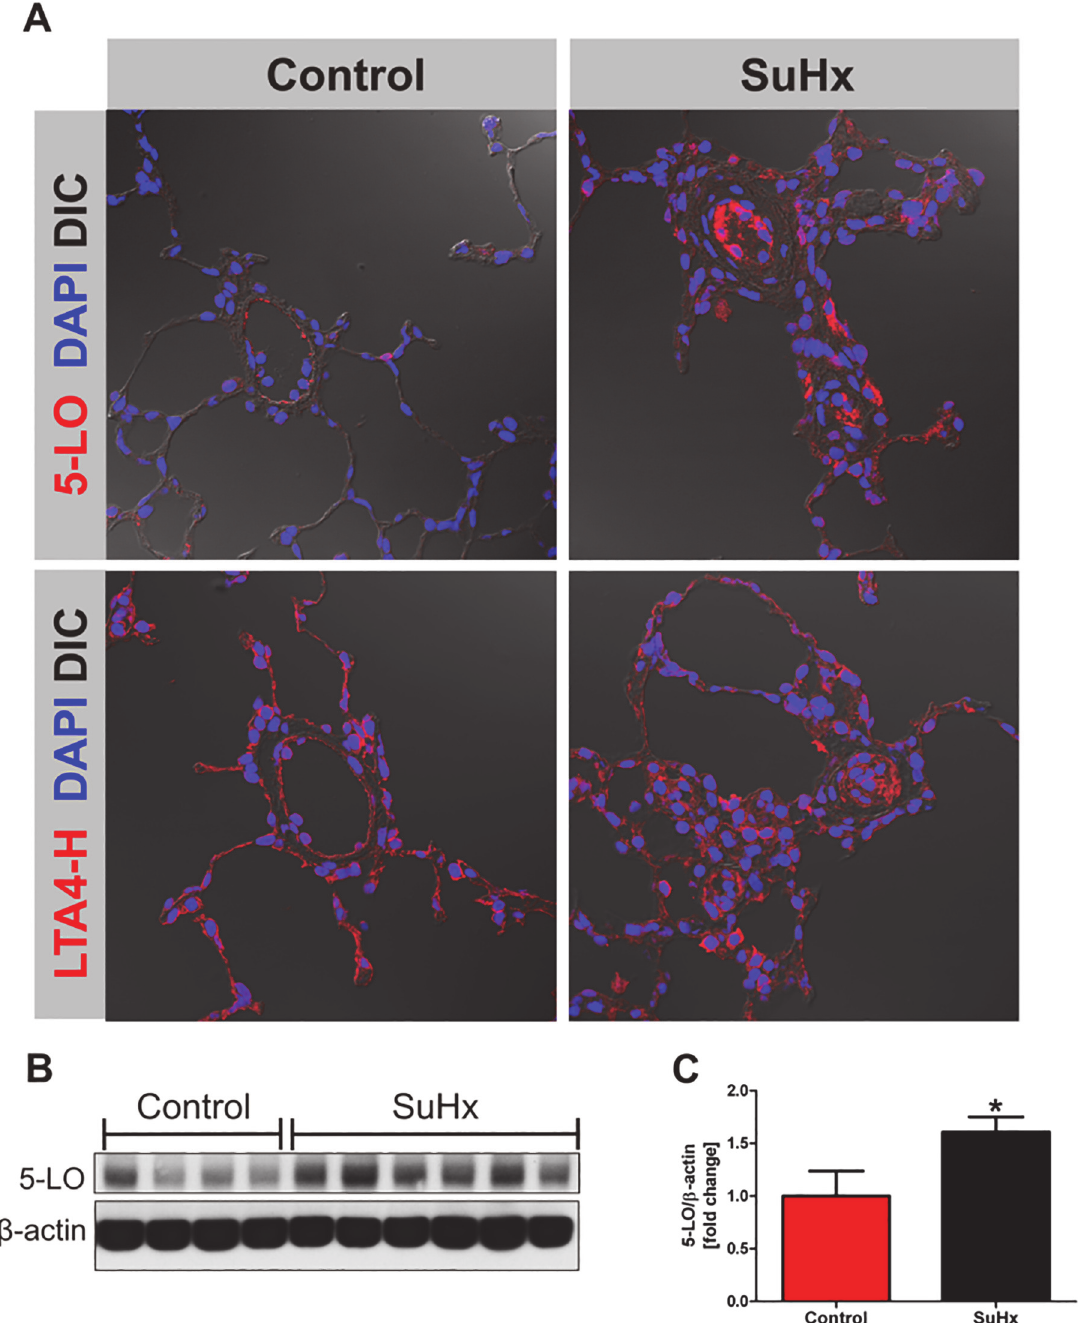
Fig 5. Immunofluorescence for representative tissue samples shows the labeling of lumen-obliterating cells; 5-LO protein expression is increased in the SuHx lungs. Antibodies directed against 5-LO and LTA4 hydrolase were used (B, D), controls (A, C). In control lung tissues there was only sparse labeling of arteriolar endothelial cells for 5-LO, while the LTA4 hydrolase antibody stained alveolar septal cells in addition. In the lungs from the SuHx rats many of the lumen obliterating cells and also perivascular cells were intensely labeled by both antibodies. DAPI = nuclear staining, DIC = differential interference contrast, 5-LO = 5-Lipoxygenase, LTA4-H = Leukotriene A4 hydrolase, magnification 40X. The lung tissue 5-LO protein concentration was increased in the SuHx lungs when analyzed by western blot. (n = 4 – 6).